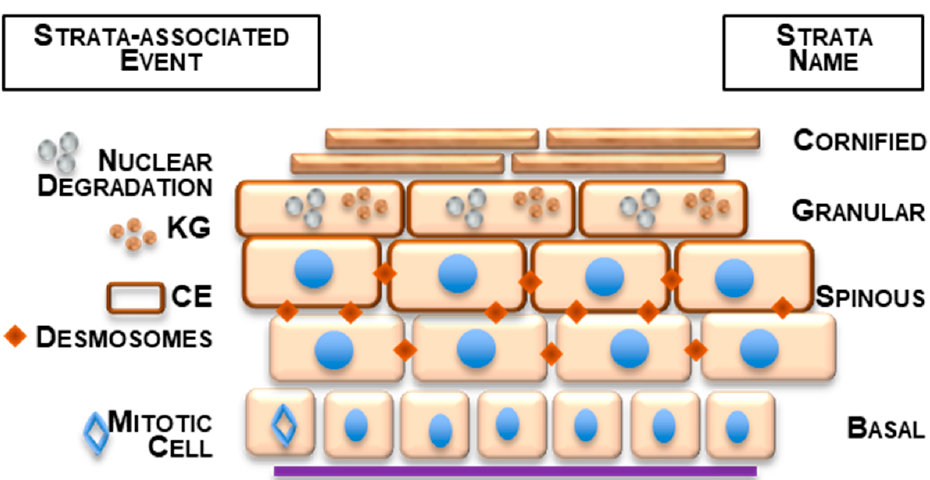
Figure 1. Simplified schematic of keratinocyte stratification in the human epidermis. KG indicates SFTP synthesis and keratohyalin granule formation. CE indicates cornified envelope protein synthesis and assembly. Desmosomes indicate numerous cell–cell contacts (“spines”) formed. Strata labeled on the right. Basal keratinocytes attach to the specialized connective tissue sheet, the basal lamina, at the bottom of the diagram.